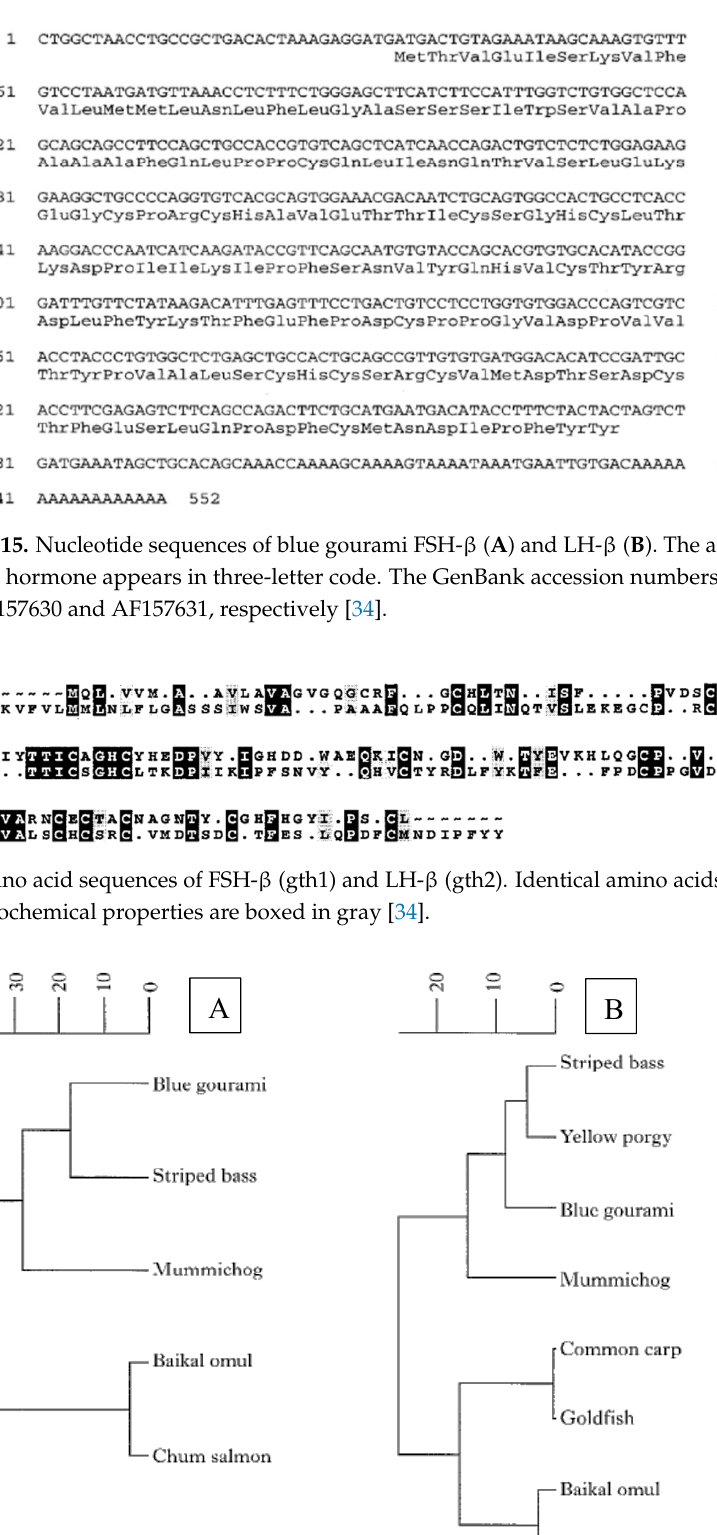
Figure 17. Phylogenetic tree showing the relationships between fish FSH- β ( A ) and LH- β ( B ) sequences. The dendrograms were created by the UPGMA method from similarity matrices that were produced from the corresponding sequence alignments. The scale bar is a measure of the estimated number of amino acid substitutions per 100 residues in pairwise comparisons [34,35].